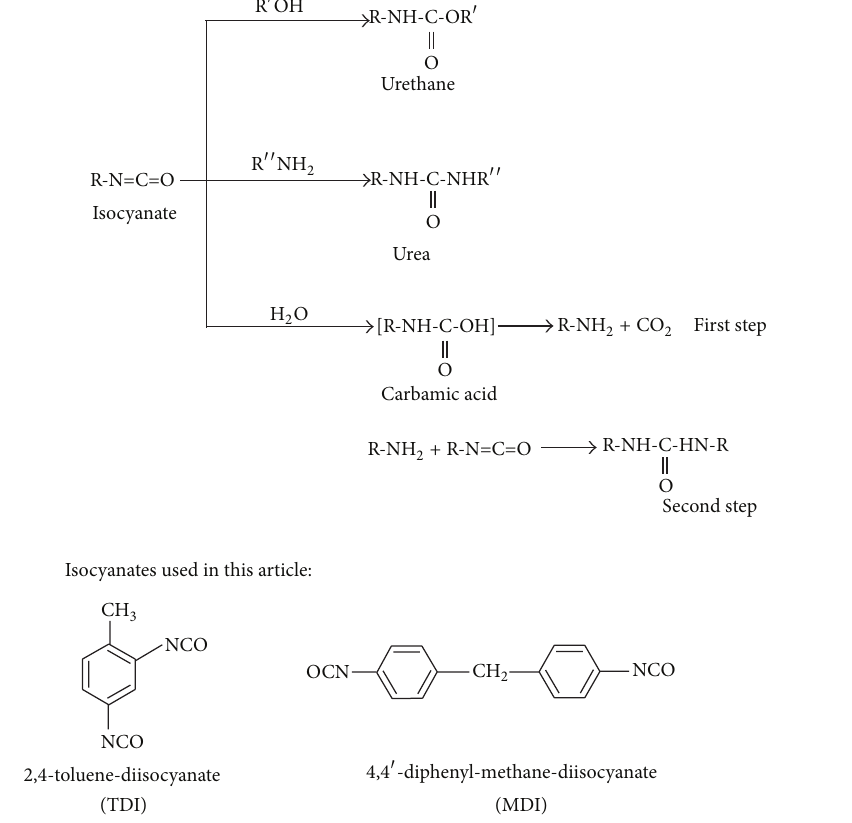
Figure 2: Scheme of possible reactions of isocyanates with moieties of polyethylene glycol-keratin-water system. where 𝐶 𝑖 indicates the initial concentration of Cr(VI): 20 mg/L; 𝐶 𝑡 corresponds to the effluent concentration at predetermined time, the latter is obtained from a calibration curve according to the UV-Vis spectrophotometric